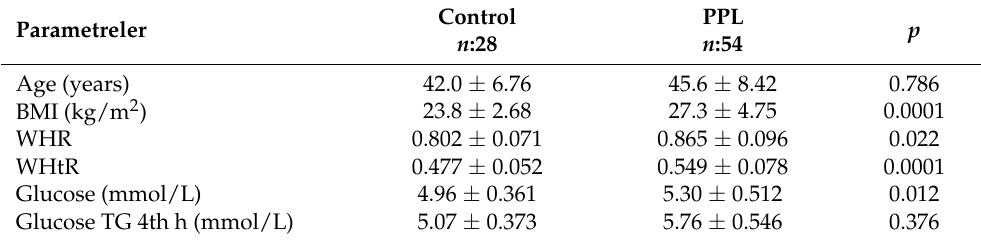
Table 1. Anthropometric measurements and biochemical variables in the study group. Parametreler